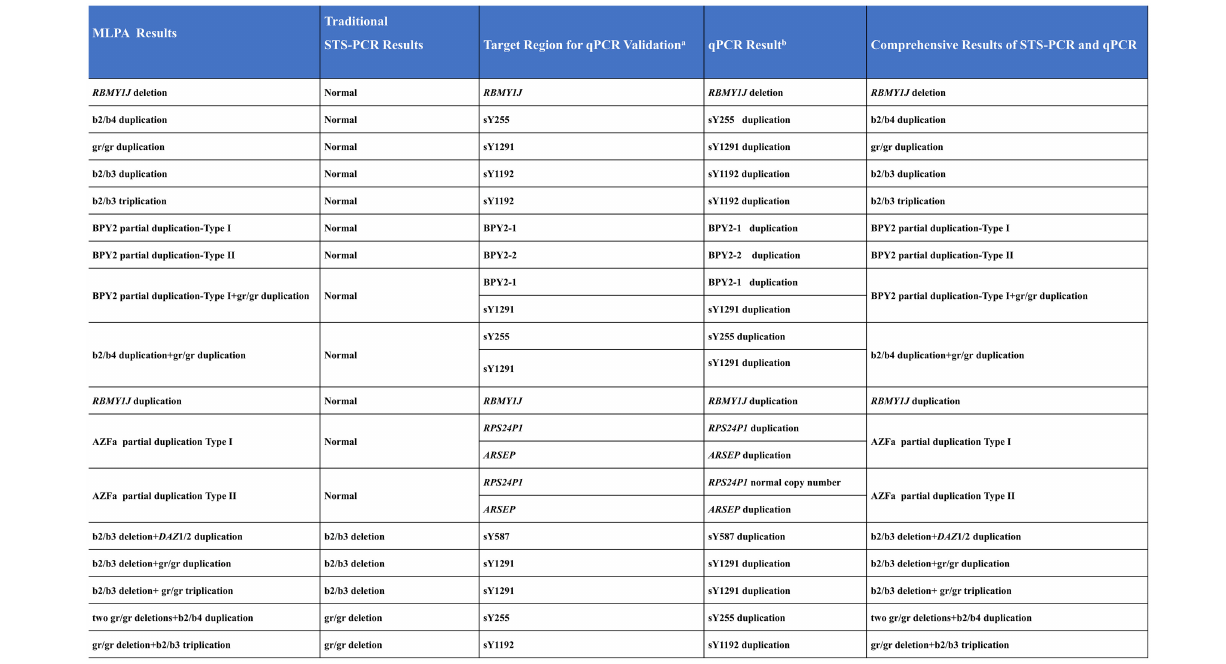
FIGURE 5 | Comprehensive results of STS-PCR and qPCR validation. a , Special regions of target AZF-linked CNVs for qPCR validation; b , Simplified qPCR results. Detailed qPCR results see Supplementary Figure S2